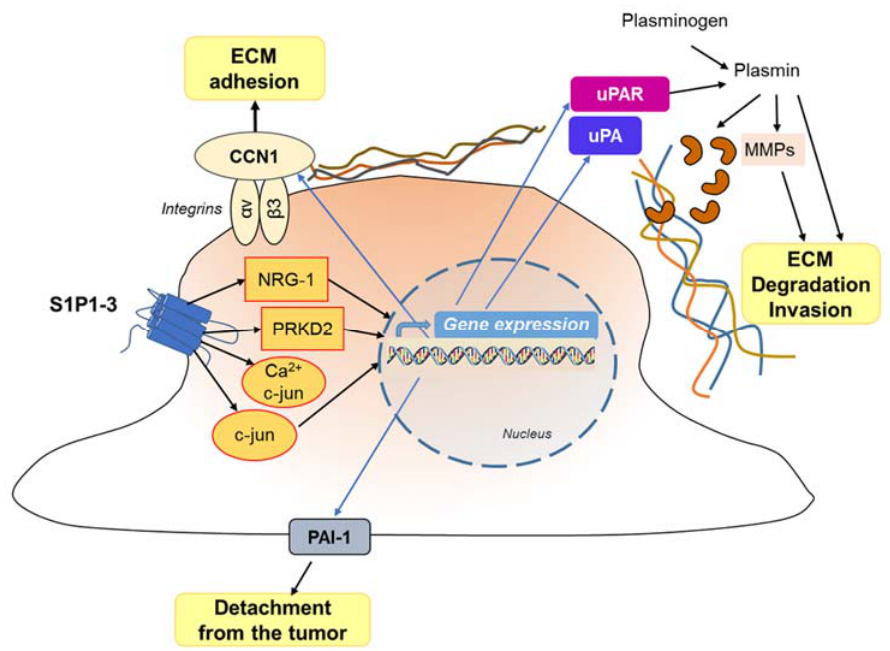
Figure 5. E ff ect of S1P on GBM invasivity. The interaction of S1P with its receptors results in the activation of di ff erent signaling pathways, and enhanced gene and protein expression, leading to detachment (at the trailing edge) and attachment (at the leading edge) of the migrating cell, with stimulation of the extracellular matrix degradation favoring and cell invasion.